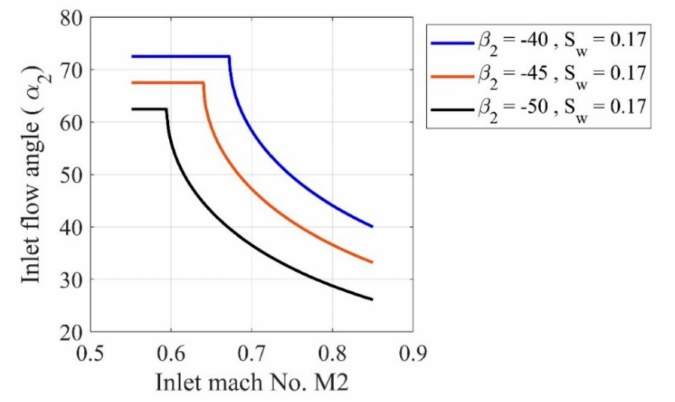
Figure 3. E ff ects of the Mach number on the inlet flow